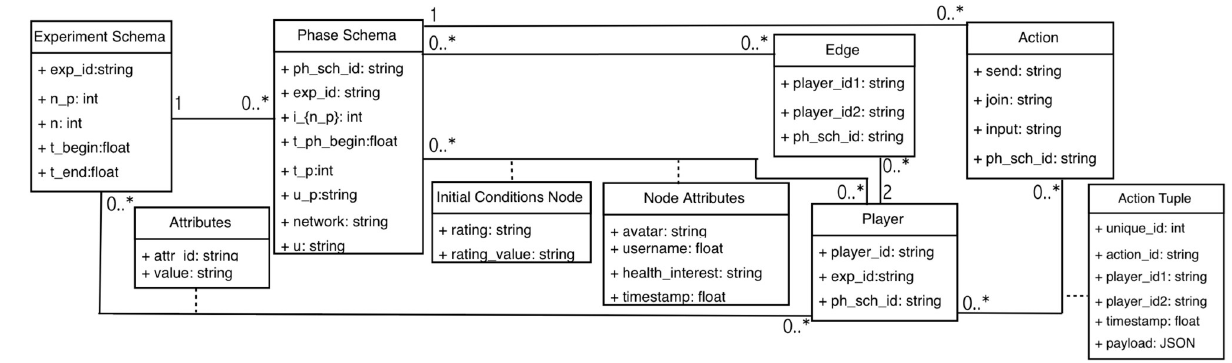
Fig 33. Data model of Table 14 translated into a entity-relationship diagram in Unified Modeling Language (UML) form.